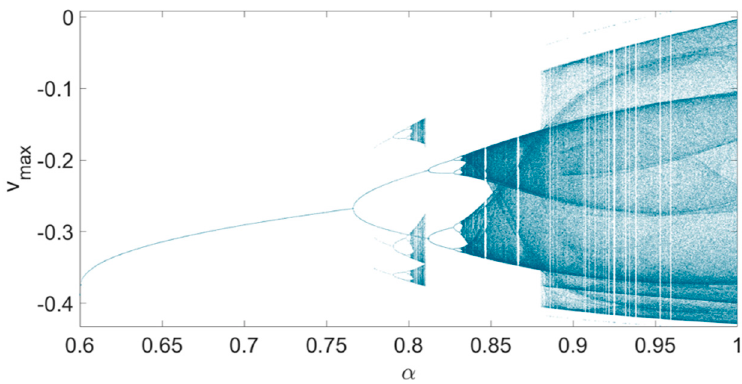
Figure 1. The bifurcation diagram of FMW neuron as a function of fractional order α . Other parameters are C m = 1, E Na = 0.95, E K = − 0.95, g K = 26, t r = 5, t φ = 0.5, a = 1, b = 3, k = 8.5, and ε = 1. The initial condition is ( v 0 , r 0 , φ 0 ) = ( 0,1,0 ) . The phase portraits of the FMW neuron in 3-D variable space by considering α =